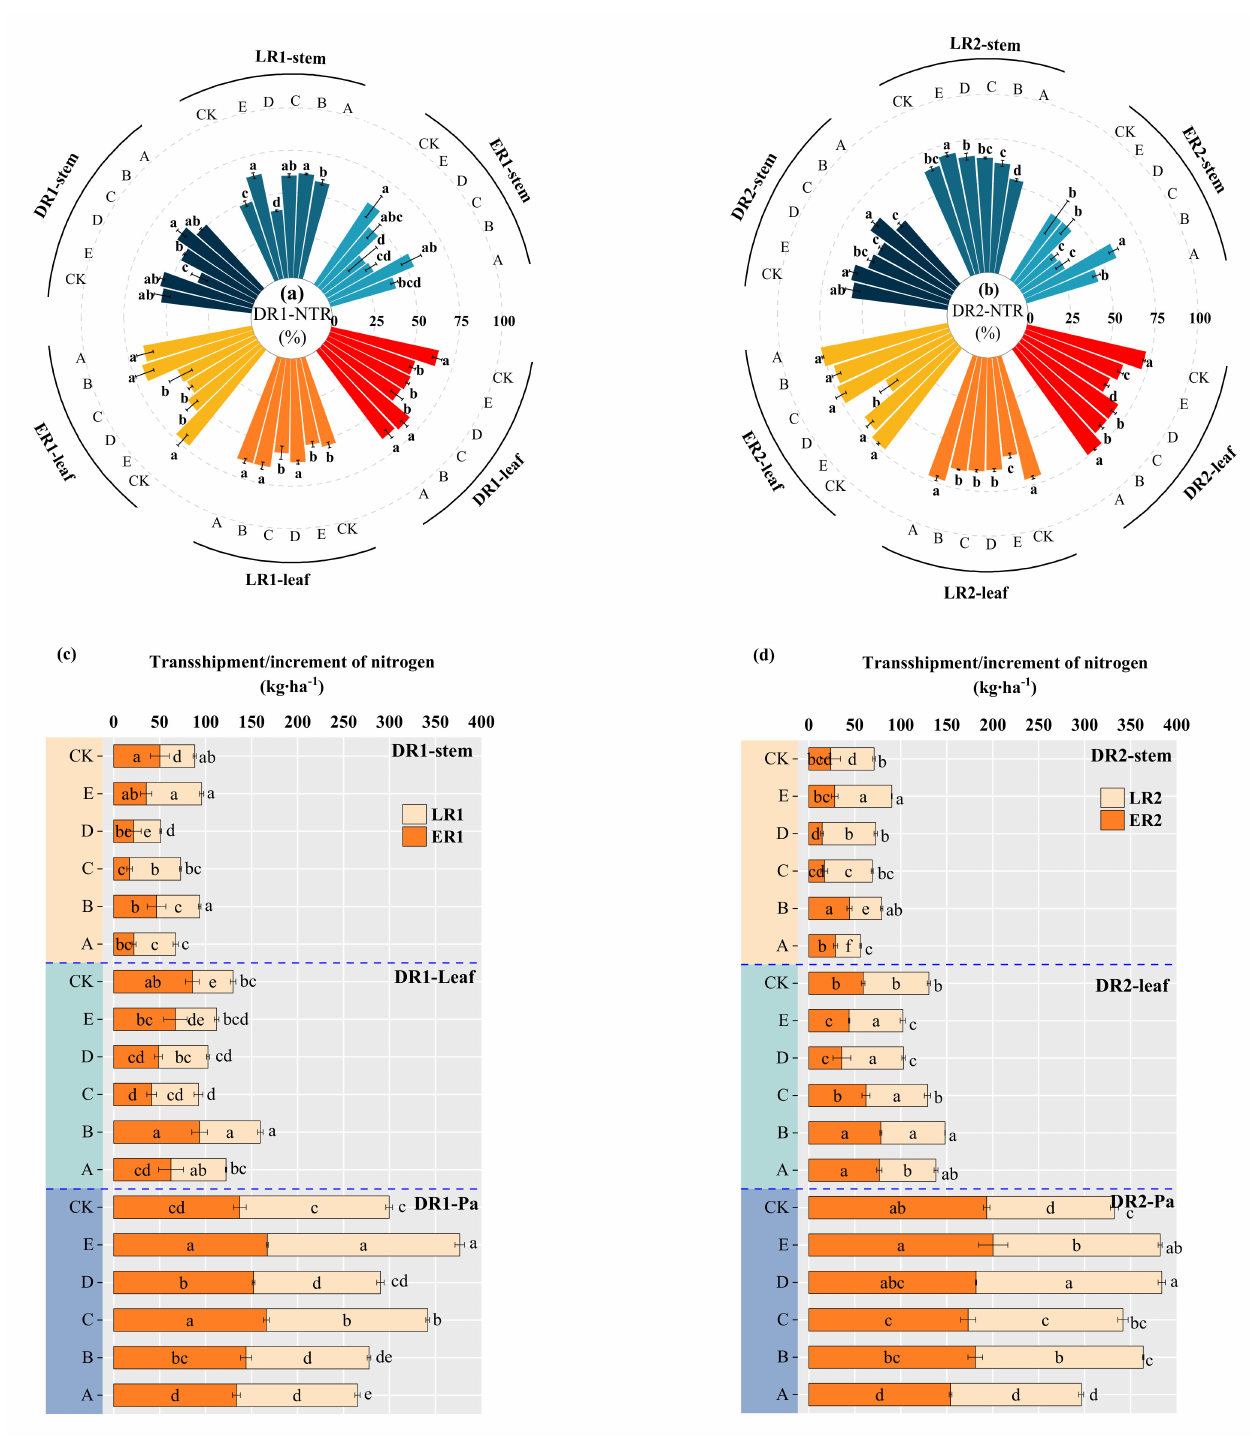
Figure 3. Translocation of nitrogen in rice organs under different nitrogen application patterns in 2016. ( a ), the translocation rate of nitrogen in DR1; ( b ), the translocation rate of nitrogen in DR2; ( c ), the translocation of nitrogen in DR1; ( d ), the translocation of nitrogen in DR2. Translocation of nitrogen in rice stem and leaf, the increment of nitrogen in rice panicle in ( c , d ). The data are presented as mean ( ± standard error). Different lowercase letters indicate significant differences between different treatments at p < 0.05. ER, early-season rice; LR, late-season rice. ER1, LLY996; LR1, YZX; ER2, ZZ39; LR2, FYY299. DR, double-season rice; DR1, LLY996 + YZX; DR2, ZZ39 + FYY299; NTR, the translocation rate of nitrogen; Pa,